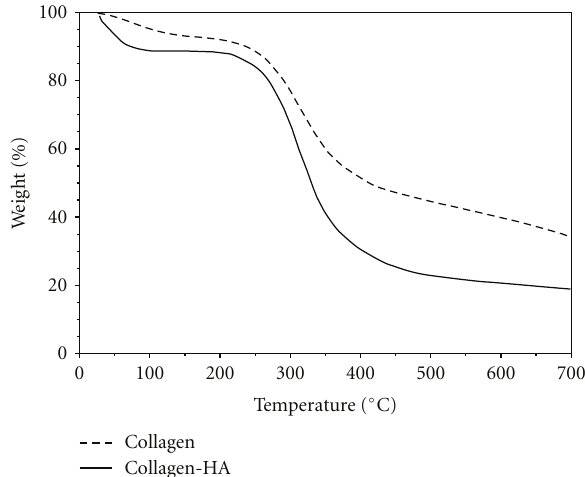
Figure 2: TGA curves of electrospun pure collagen (straight line) and collagen-hydroxyapatite composite (dotted